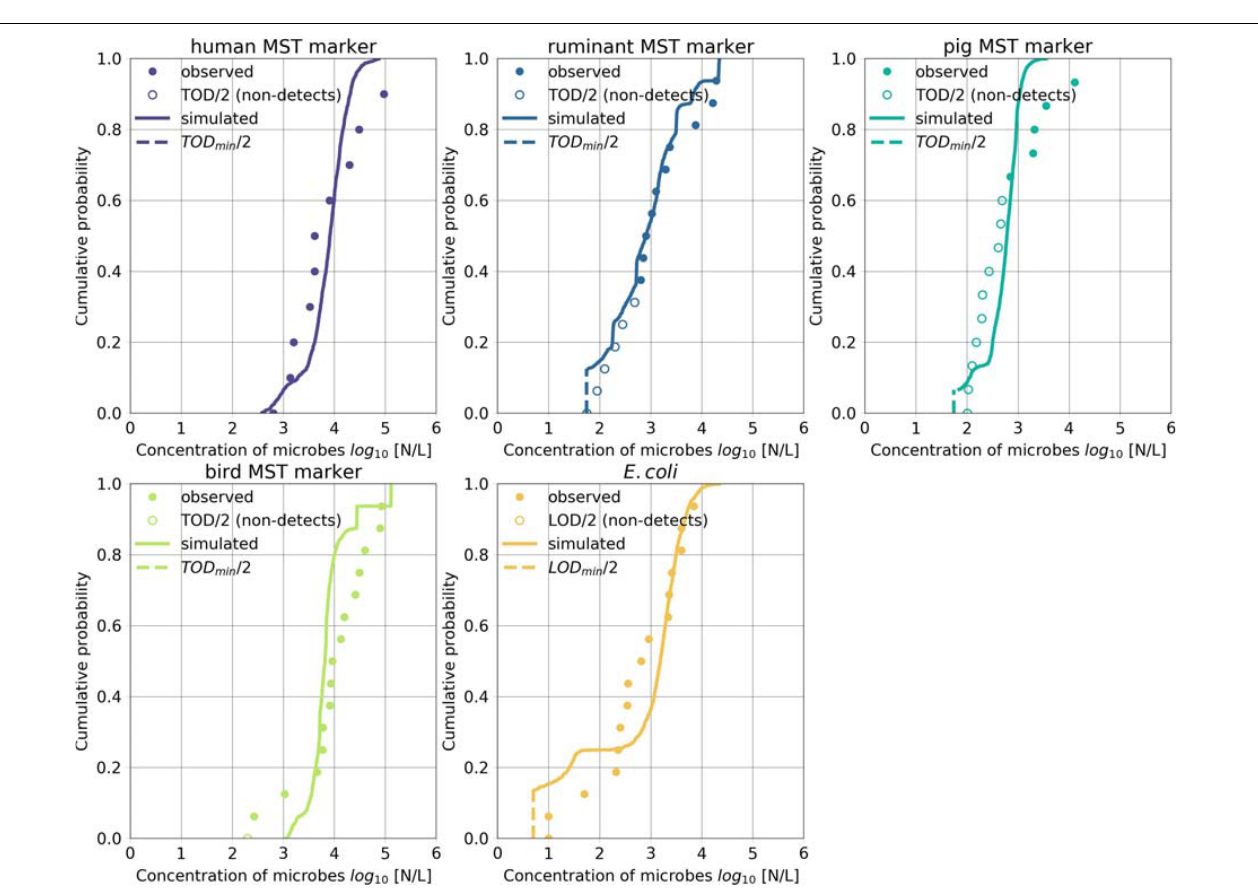
FIGURE 5 | Microbial fate and transport model performance. Simulated and observed concentrations of the host-associated MST markers and of E. coli during days when Danube water discharged into the backwater branch or on rainy days. Non-detects were replaced by half of the TOD (MST markers) or LOD ( E. coli ). Simulated values below the LOD or the lowest TOD (TOD min ) were set to half of the LOD or the TOD min .